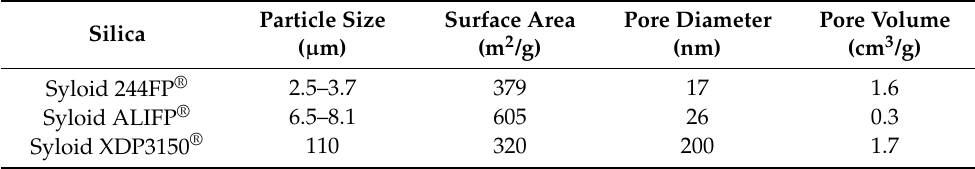
Table 3. Properties of mesoporous